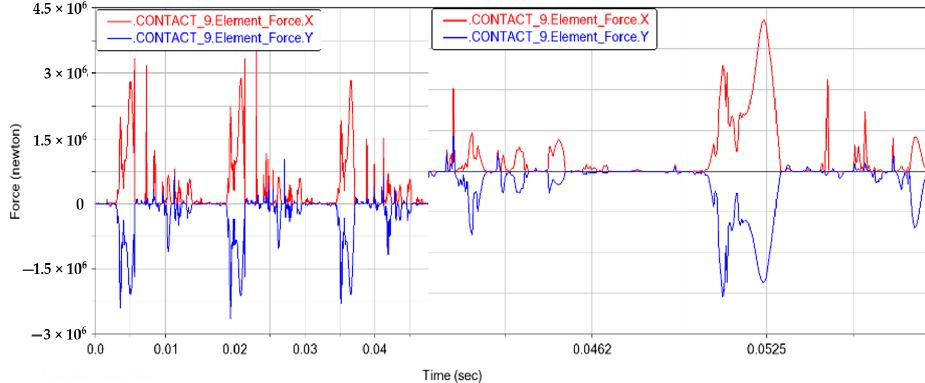
Figure 21. Third crank pin tangential (Y)/diameter (X) direction force curve.